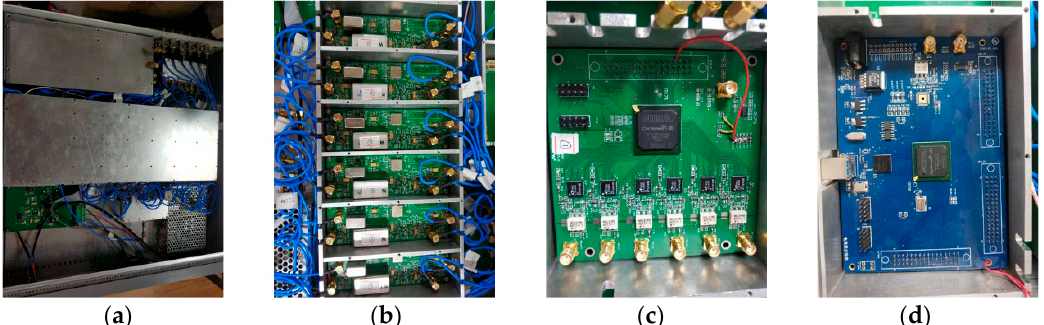
Figure 3. ( a ) The overall structure of the receiver; ( b ) the boards of the analog leading-ends; ( c ) the photo of the ADC board; ( d ) the photo of the DDC board.